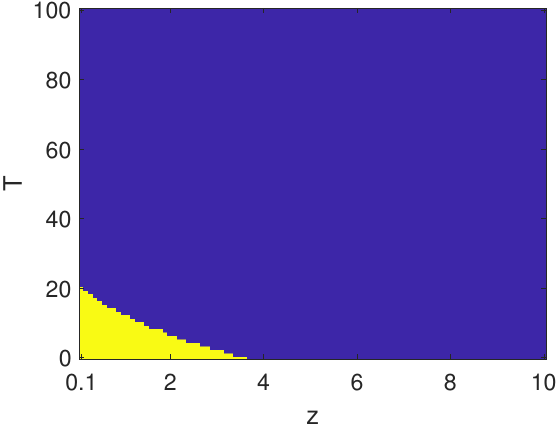
Figure 12. The boundary in the parameter space z − T between the stability (yellow) and instability (blue) regions, for k = 100. Other parameters are as reported in the caption of Figure 8.